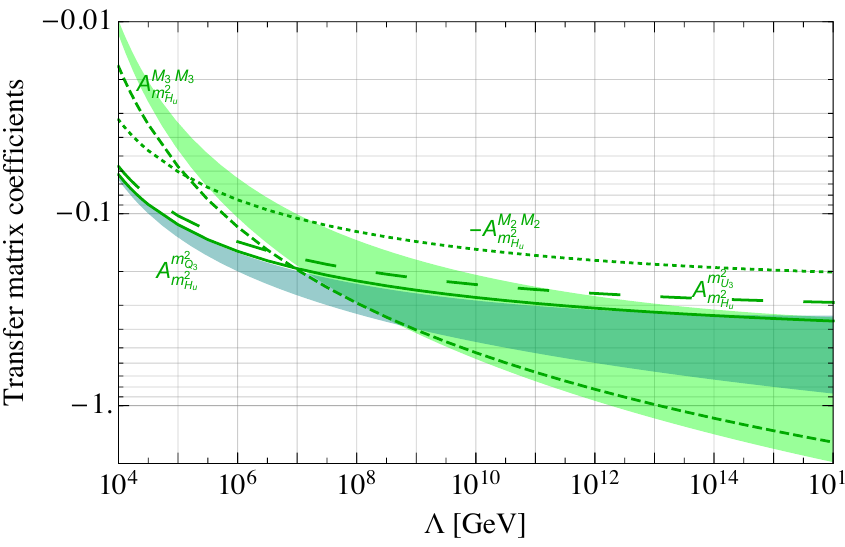
Figure 1 . Relevant transfer matrix coe(cid:14)cients for m 2 for Q = 1 TeV and tan (cid:12) = 20. The solid and long-dashed lines show coe(cid:14)cients for the terms proportional to the squared squark masses m 2 are the coe(cid:14)cient for the terms porportional to M 2 uncertainties in the LL approximations, by taking the LL formulas (1.5){(1.6) with y t and (cid:11) s evaluated at the weak scale (lower boundary) or at the messenger scale (upper